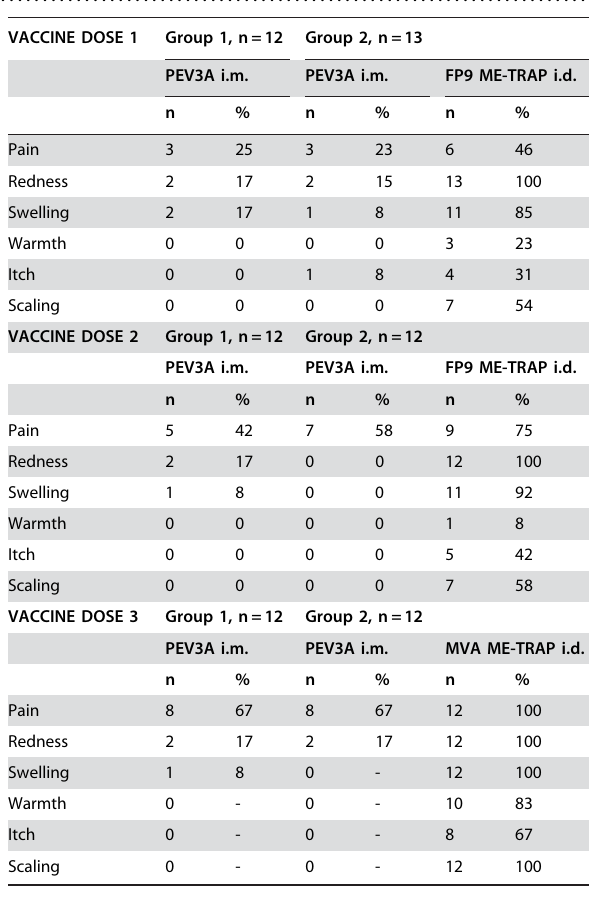
Table 3. Frequency of solicited general symptoms after each